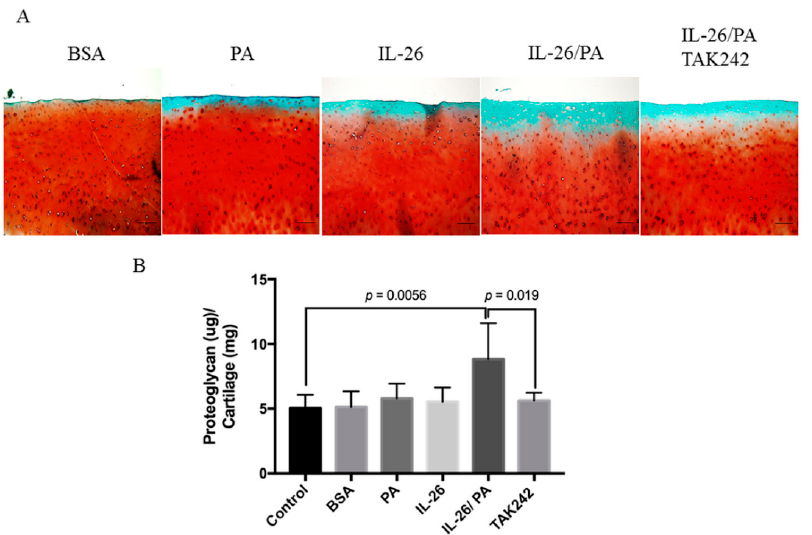
Figure 5 . Effects of IL-26 and palmitate on human cartilage explants. Full-thickness cartilage